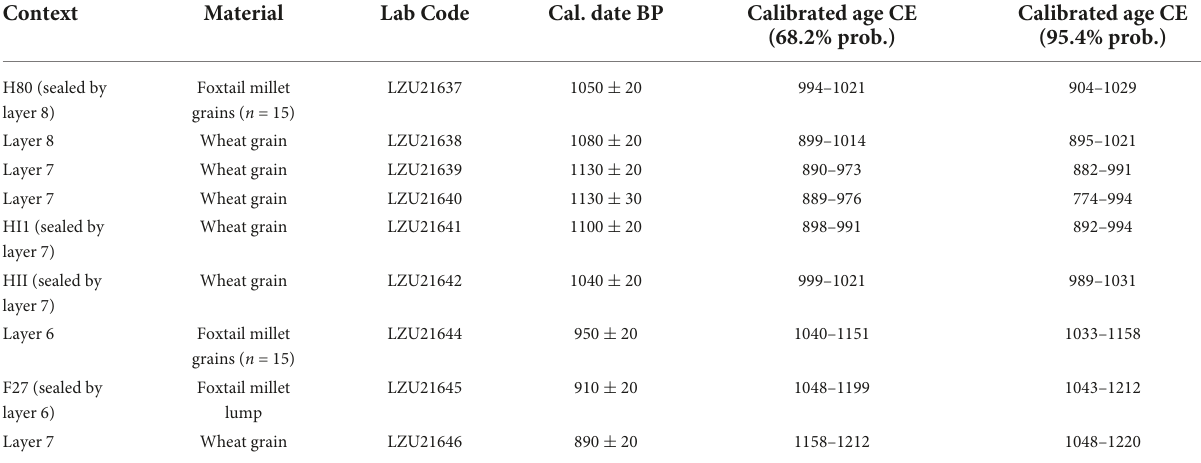
TABLE 1 Radiocarbon dates from ZKS site. Calibrated ranges are given at 68.2 and 95.4% probabilities using OxCal 4.4 and the IntCal20